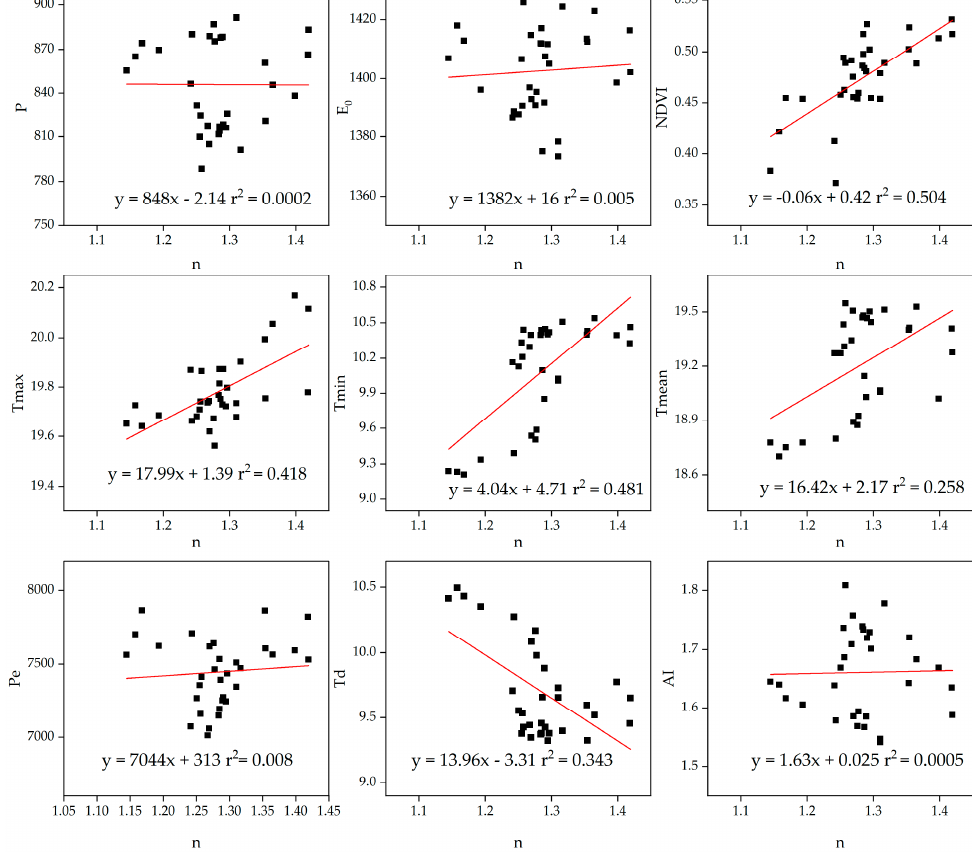
Table 3. Elasticity and significance of logarithmic function of climate change and ecological resto- ration on watershed factor ( n ).